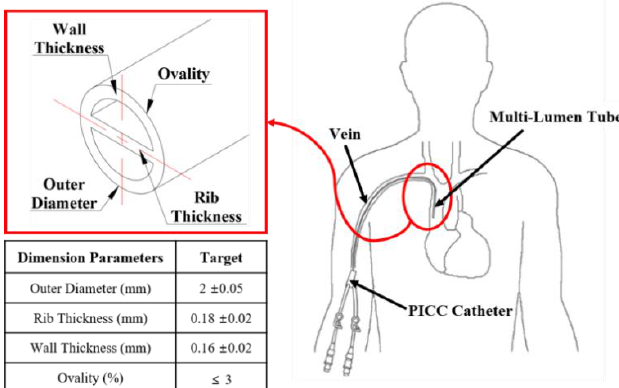
Figure 1. Cross-sectional profile dimensions of target multi lumen tube for peripherally inserted central catheters (PICCs).